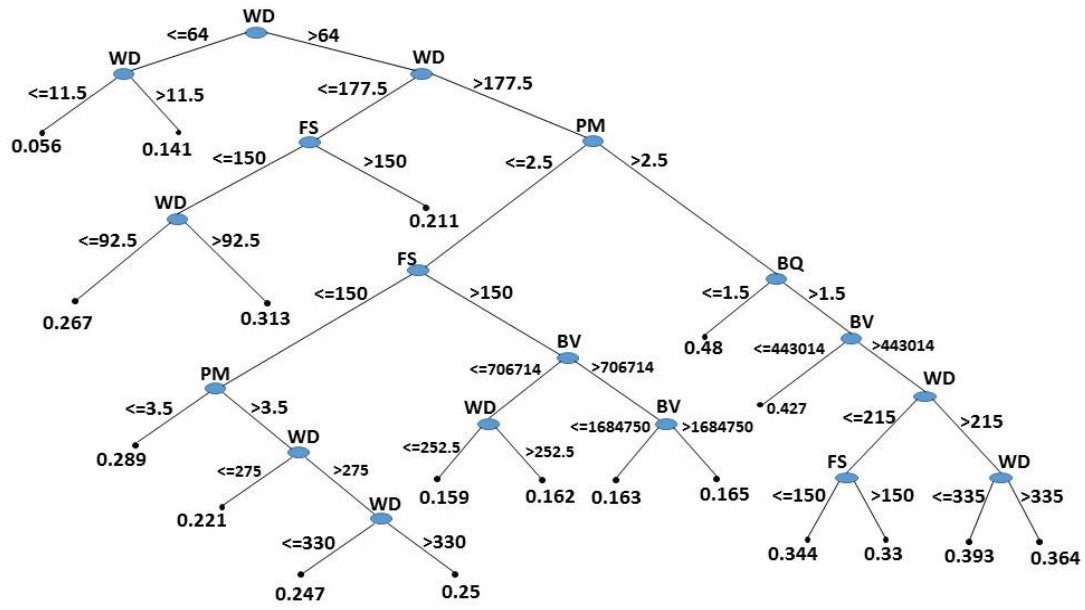
Figure 9. Regression tree with 19 leaves for estimating the structural loss ratios (WD: water depth, FS: floor space, PM: precaution measures, BV: building value, BQ: building quality). Table 3. Damage-influencing variables of regression tree with 19